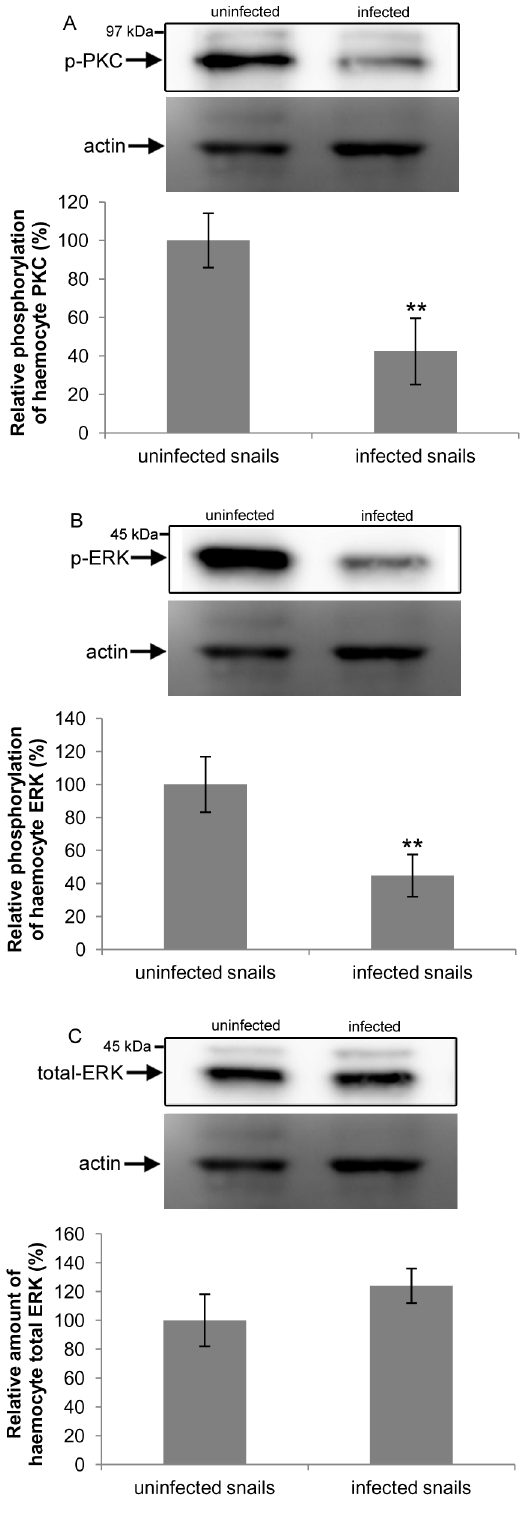
Figure 7. PKC and ERK phosphorylation and total ERK levels in haemocytes from uninfected and Trichobilharziaregenti infected Radix lagotis . Representative blots showing (A) PKC and (B) ERK phosphorylation in adherent haemocytes from uninfected and infected snails. (C) Levels of total ERK in uninfected and infected snails. Band intensities were measured and the mean ( 6 SEM) haemocyte PKC and